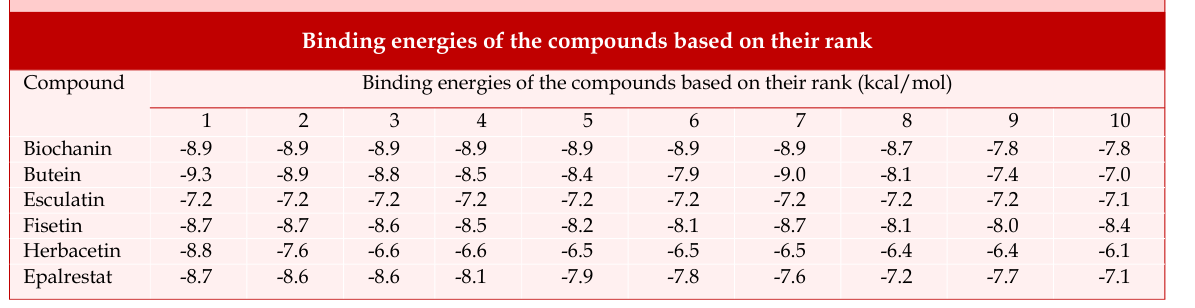
Binding energies of the compounds based on their rank (kcal/mol) Compound